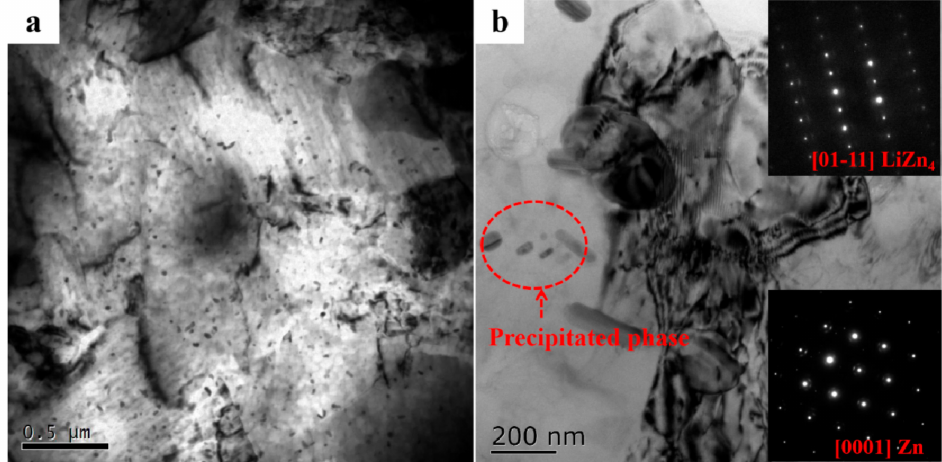
Figure 5. TEM images of the Zn-0.5%Li-0.1%Ag alloy: ( a ) low magnification microstructure and ( b ) high magnification